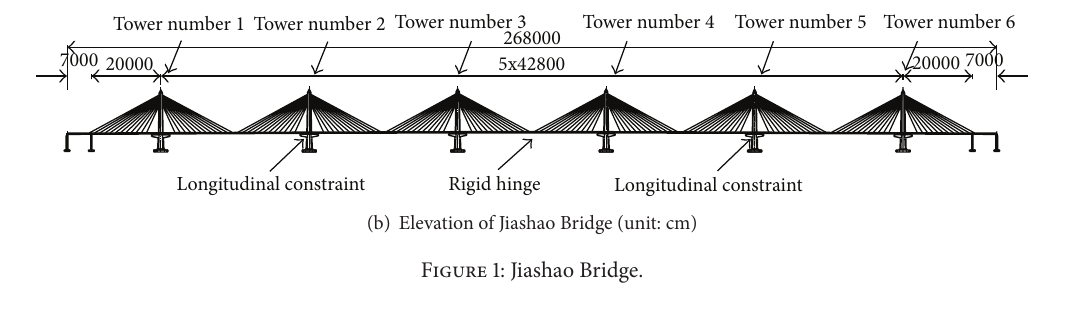
Figure 1: Jiashao Bridge.